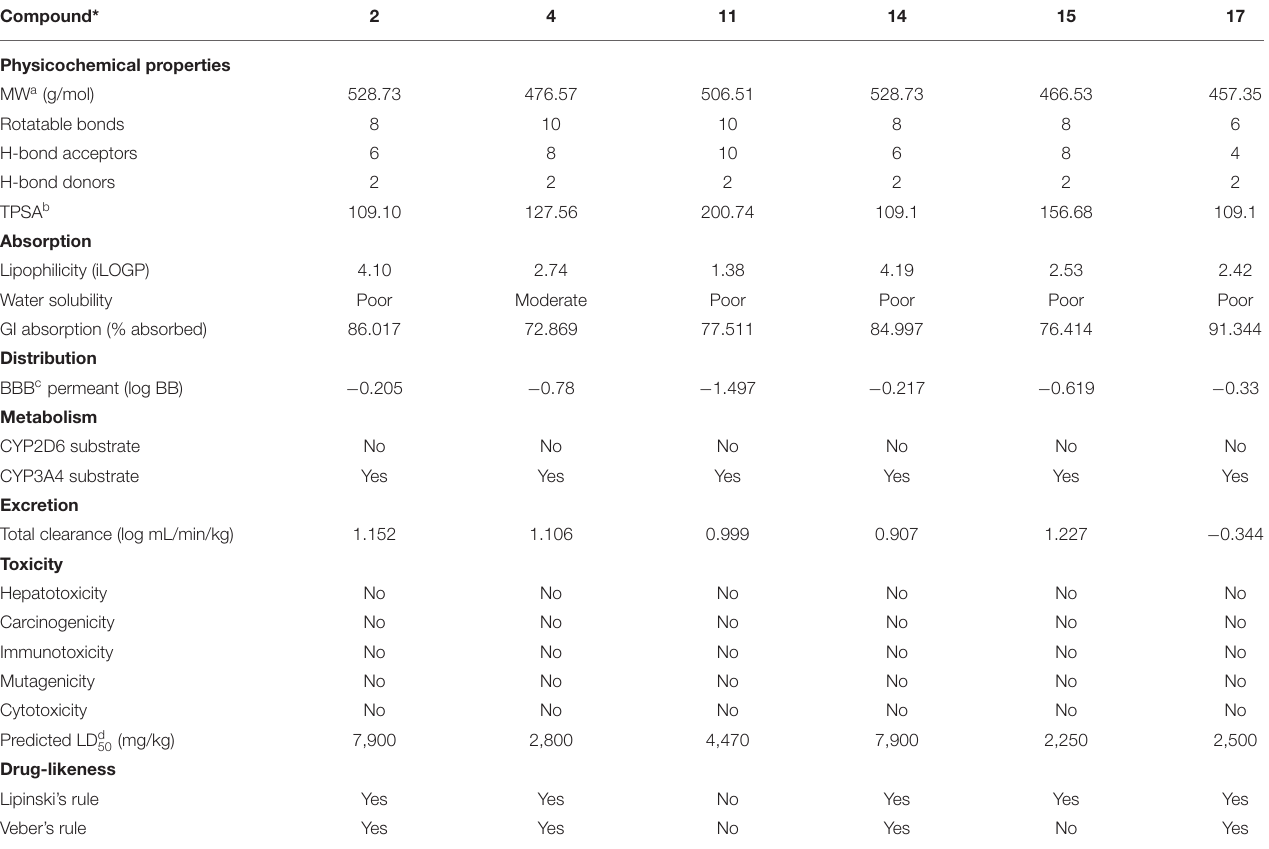
TABLE 1 | Predicted # physicochemical characteristics, pharmacokinetic and toxicity profile, and drug-likeness of the selected bis-sulfonamides ( 2 , 4 , 11 , 14 , 15 , and 17 ) # .